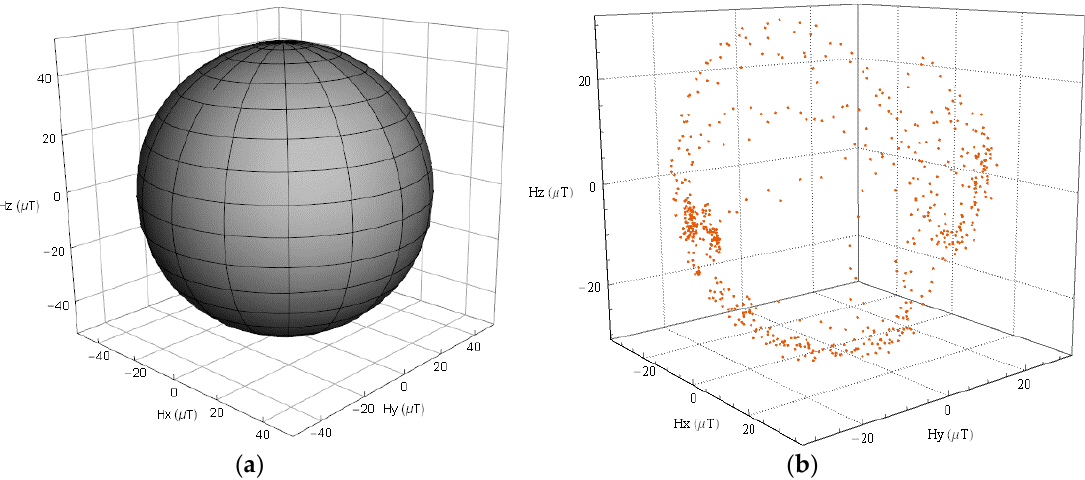
Figure 2. 3-dimension locus magnetic field measurements, ( a ) error-free, ( b ) contaminated by hard iron, and scale factor error.